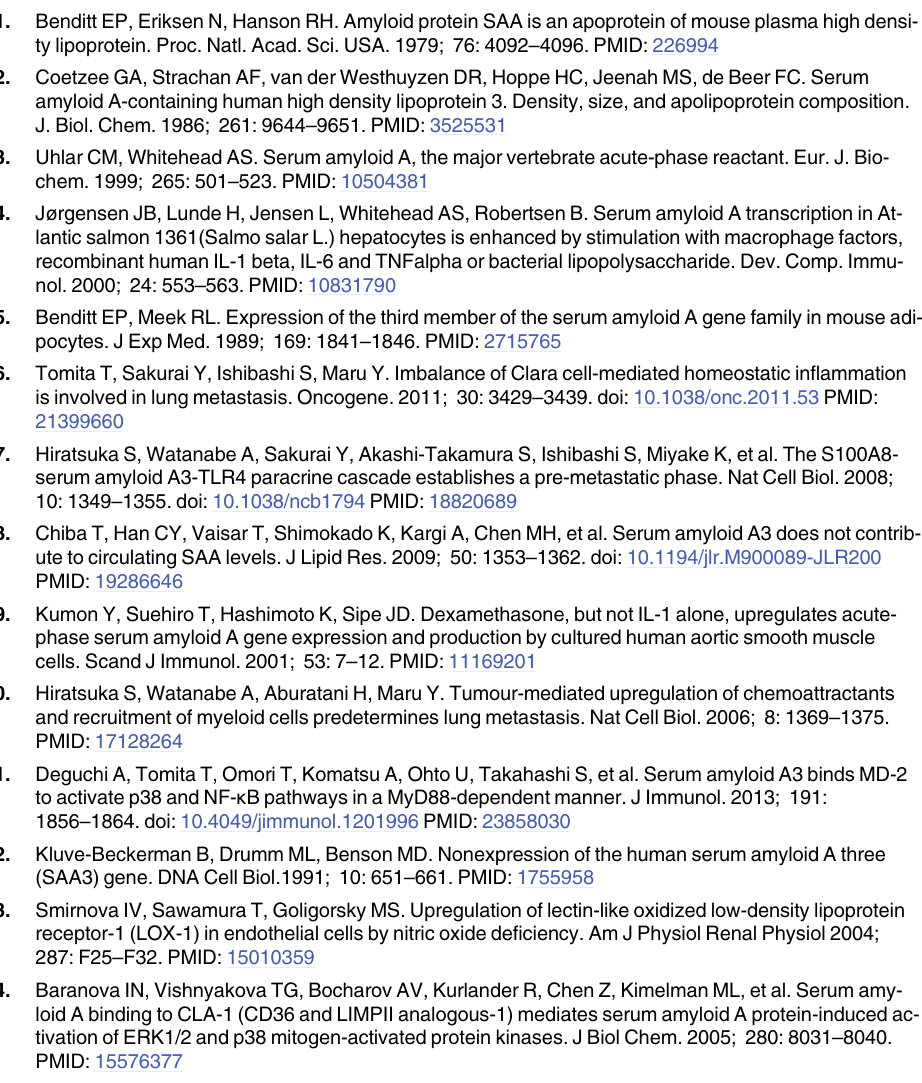
S2 Table. Statistical hypothesis testing information for Fig. 2C showing relative hSAA2 copy number. S3 Table. Statistical hypothesis testing information for Fig. 2D showing relative hSAA3 copy